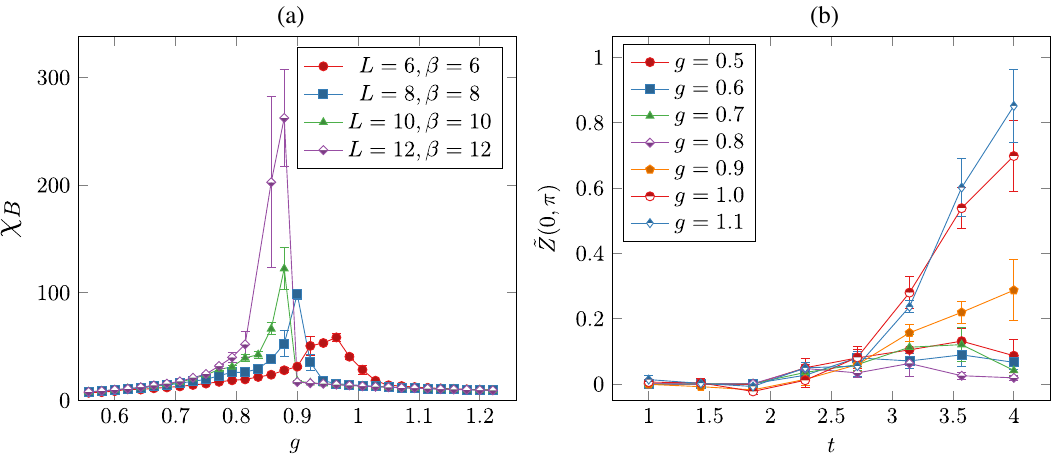
FIG. 5. (a) Flux susceptibility χ as a function of g for t ¼ 3 . 0 along the path connecting the confined and deconfined FL phases. B ˜ Z (b) Single-particle residue ð k Þ evaluated at the antinodal point k ¼ f 0 ; π g as a function of t . Different curves correspond to different values of g